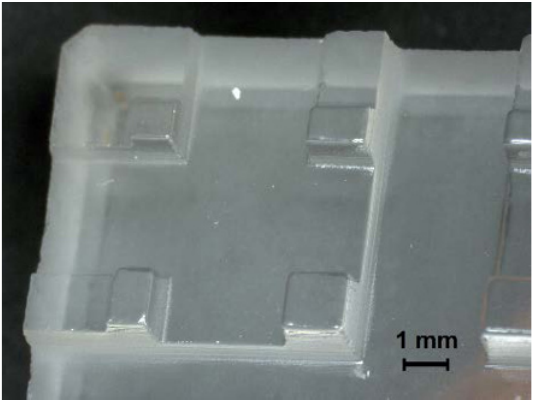
Fig. 10. Functional verification on a laser-polished array structure.